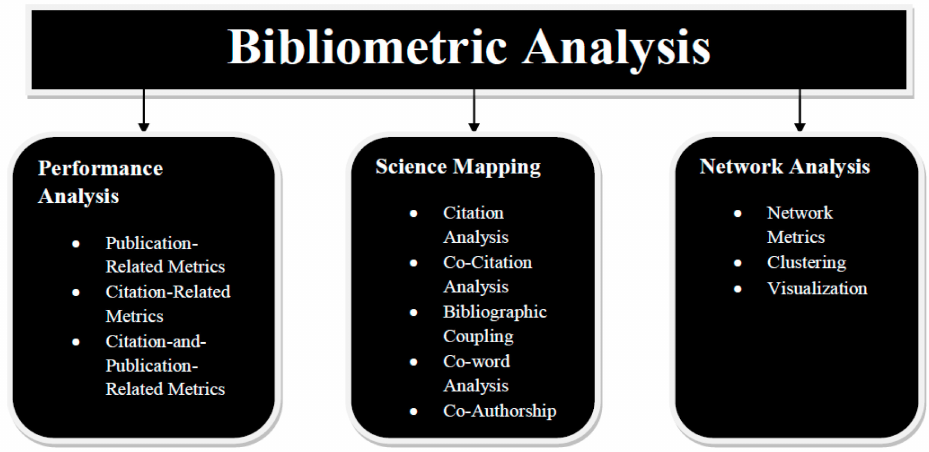
Figure 12. Various forms of bibliometric